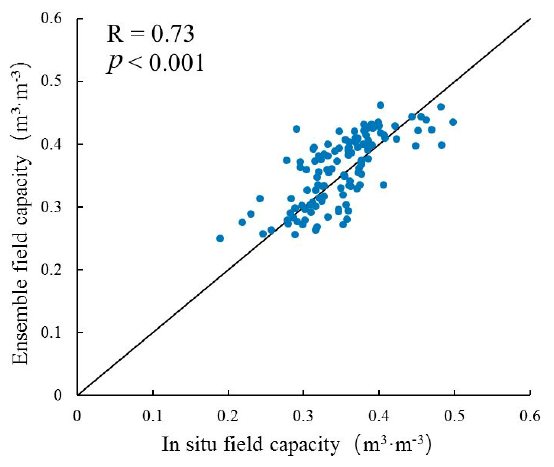
Figure 7. Comparison of in situ field capacity and ensemble field capacity at the region scale. Here p values represent confidence interval. Soil units in which the number of stations was no more than two are excluded.